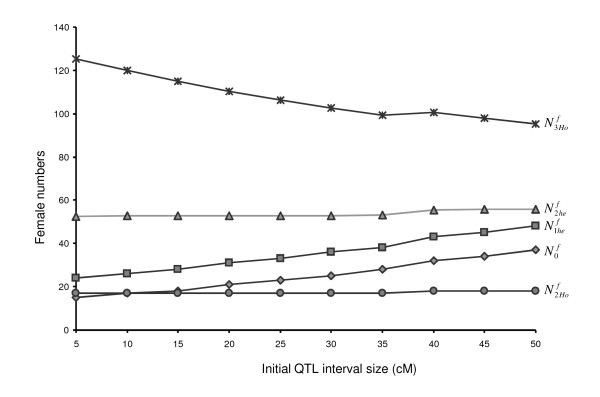
Dam sample sizes as a function of the initial interval size θ to obtain a resolution δ of 2.5 cM.